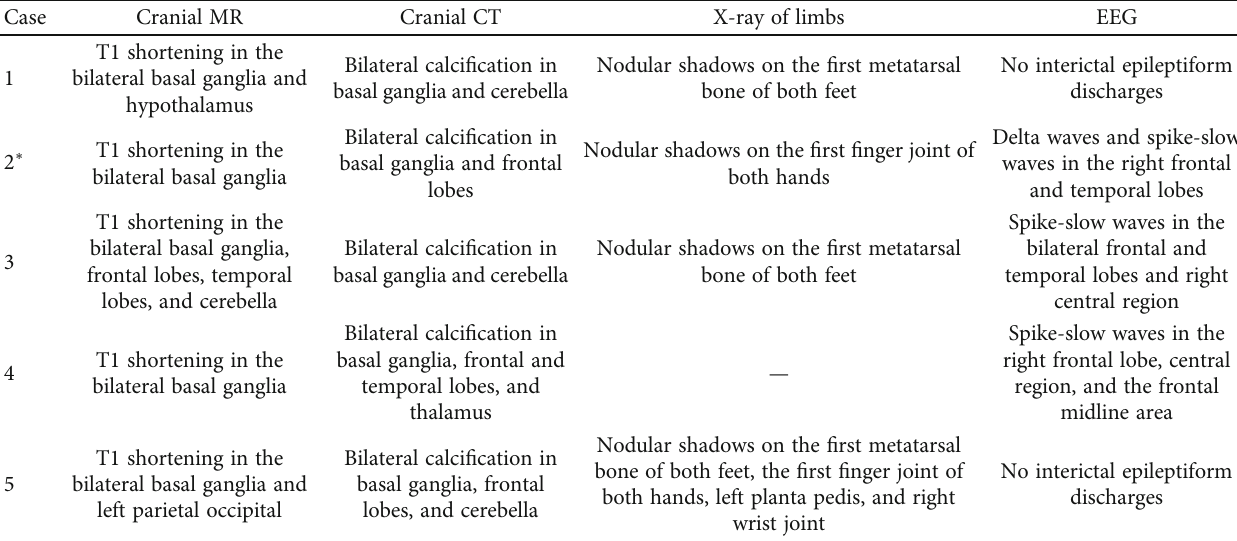
Table 3: Summary of results regarding imaging tests and EEG